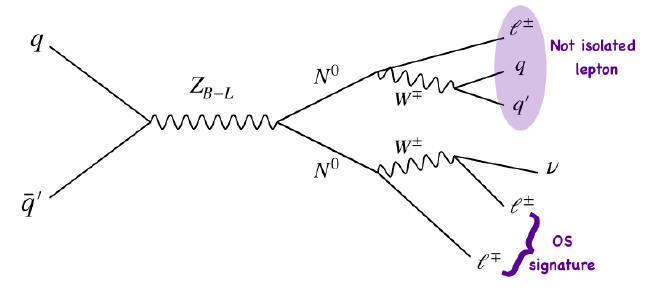
Figure 15. A schematic diagram of getting more OS over SS in boosted scenario.